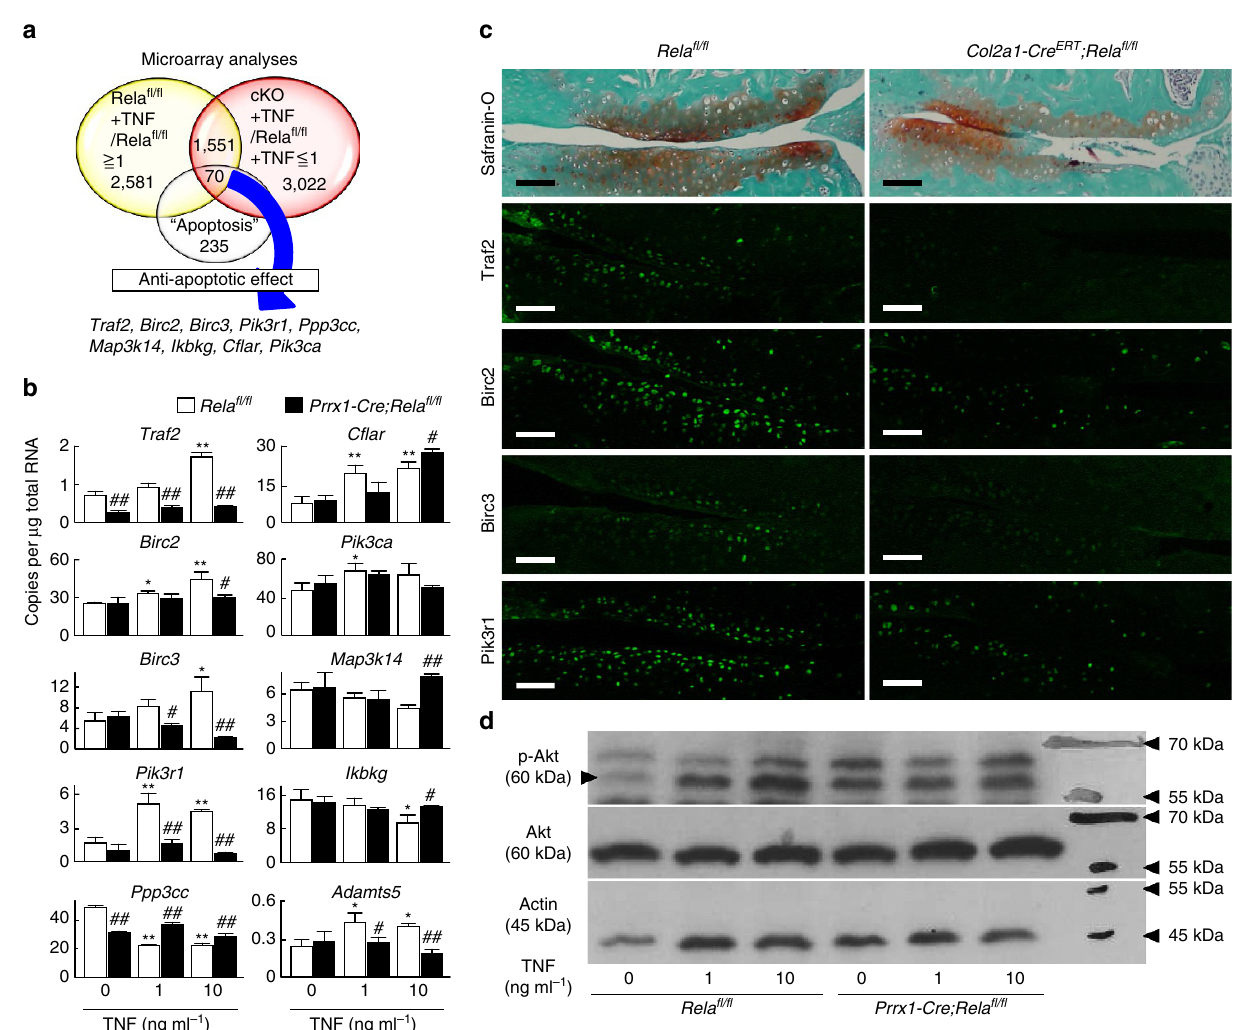
Figure 5 | Transcriptional target genes of Rela. ( a ) Schematic diagram to identify candidate genes by microarray analyses. cKO, Prrx1-Cre; Rela fl/fl . ( b ) mRNA levels of candidate genes and Adamts5 in primary chondrocytes obtained from Rela fl/fl and Prrx1-Cre; Rela fl/fl (P5) mice with or without TNF treatment. Data are expressed as the means ± s.d. of three wells per group. # P o 0.05, ## P o 0.01 versus the respective Rela fl/fl control treated with the same dose of TNF; Student’s t -test. * P o 0.05, ** P o 0.01 versus Rela fl/fl cells without TNF treatment; Student’s t -test. ( c ) Safranin-O staining and immunofluorescence of Traf2, Birc2, Birc3, Pik3r1 and Rela in knee joint cartilage of Rela fl/fl and Col2a1-Cre ERT ; Rela fl/fl littermates at 8 weeks after surgery. The images are representative of three independent experiments. Scale bars, 100 m m. ( d ) Immunoblotting of total cell lysates of Rela fl/fl and Prrx1-Cre; Rela fl/fl chondrocytes using antibodies against Ser-473-phosphorylated Akt (p-Akt), Akt and actin with or without TNF treatment. The images are representative of two independent